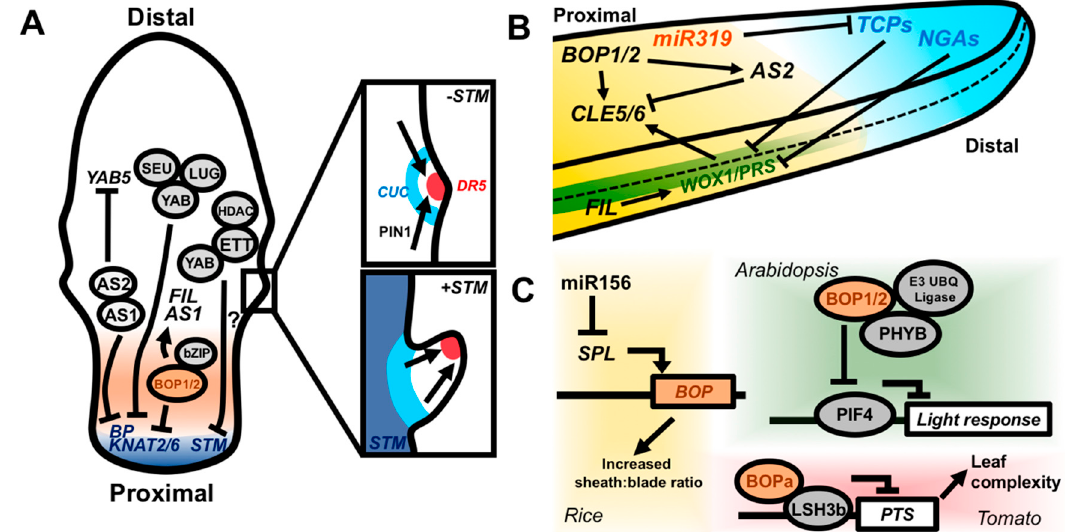
Figure 4. Molecular coordination of the proximodistal and mediolateral leaf axes. ( A ) The Class I KNOX genes BP and KNAT2 / 6 are repressed by the AS1–AS2 complex, as well as by YAB transcription factors in complex with the corepressors SEU and LUG. The AS1–AS2 complex is, in turn, able to repress YAB5 . YABs and ETT both repress STM expression and they can physically interact, potentially forming a repressive complex. BOP1 / 2 also repress BP and KNAT2 / 6 and promote expression of FIL and AS1 . If Class I KNOX genes are not repressed in the leaf, growth is prolonged, which ultimately leads to the formation of leaflets via PIN1, auxin, and CUC2 activity (insets). Local auxin accumulation (indicated by expression of the DR5 promoter) driven by PIN1-mediated transport, drives margin outgrowth, while CUC genes inhibit growth in the surrounding sinus region. ( B ) Side-on view of a leaf illustrating the cross-regulation of proximodistal and mediolateral patterning factors in the context of the growth arrest front. The TCP and NGA genes promote cell di ff erentiation and growth cessation in the distal portion of the leaf and are antagonized by proximally expressed miR319. TCPs and NGAs coordinately repress the expression of WOX1 / PRS to allow for growth cessation at the margin. WOX1 / PRS promote the proximal expression of CLE5 / 6 , which a ff ect leaf shape. BOP1 / 2 and AS2 also converge to promote and inhibit the expression of CLE5 / 6 , respectively. BOP1 / 2 directly promote AS2 expression. FIL may promote mediolateral outgrowth by promoting WOX1 expression. ( C ) Genetic pathways by which BOPs may integrate internal and external cues to regulate patterning processes. In rice, miR166 represses SPL expression, which, in turn, inhibits BOP expression in the juvenile phase. Low BOP expression confers an increased sheath:blade ratio in juvenile leaves. Silencing of miR156 expression in adult leaves leads to increased BOP expression, yielding reduced blade:sheath ratios. BOP1 / 2 likely also function in light signaling. Arabidopsis BOP1 / 2 interact with PHYB and an E3 ubiquitin ligase complex to degrade PIF4 and attenuate light responsive gene expression. BOPa in tomato interacts with the light response regulator LSH3b and LSH3b represses PTS expression with downstream KNOX-mediated promotion of leaf